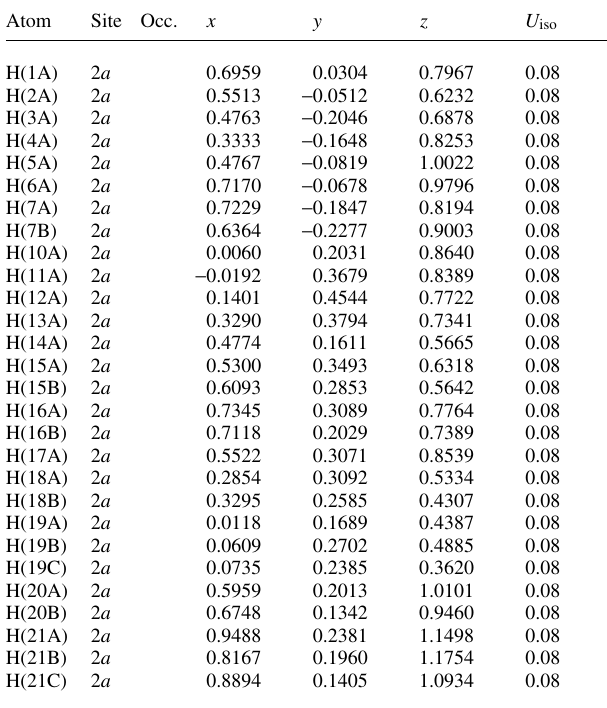
Table 2. Atomic coordinates and displacement parameters (in Å 2 )